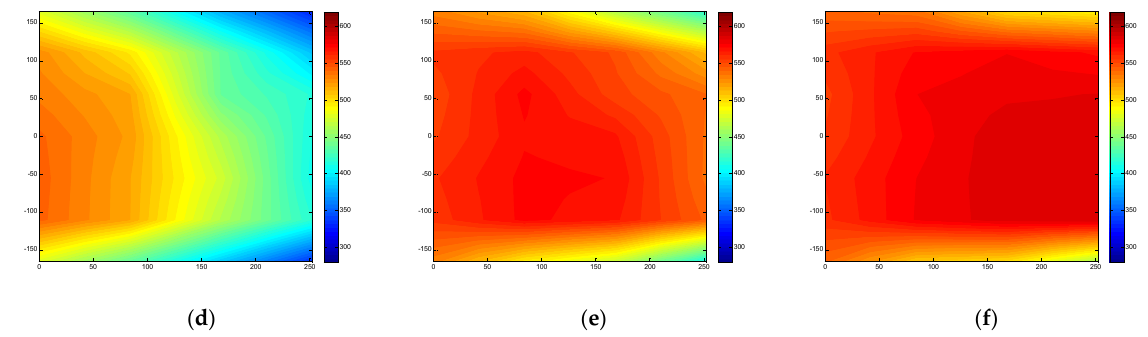
Figure 7. Temperature field variation in DPF during ignition stage. ( a ) t = 50 s; ( b ) t = 60 s; ( c ) t = 70 s; ( d ) t = 80 s; ( e ) t = 100 s; ( f ) t = 120 s. The variations in the DPF internal temperature in the regeneration stage are shown in Figure 8. During regeneration, the internal temperature of the DPF tends to change slowly and stabilizes at the DPF active regeneration setting temperature of 600 °C. At this time, the DPF axis temperature is maximized, and the edge temperature is lower than the axis temperature, primarily because the carbon load accumulated in the DPF axis is higher than the carbon load accumulated at the edge, and the carbon accumulated in the DPF regeneration stage is oxidized to release a large amount of heat energy.